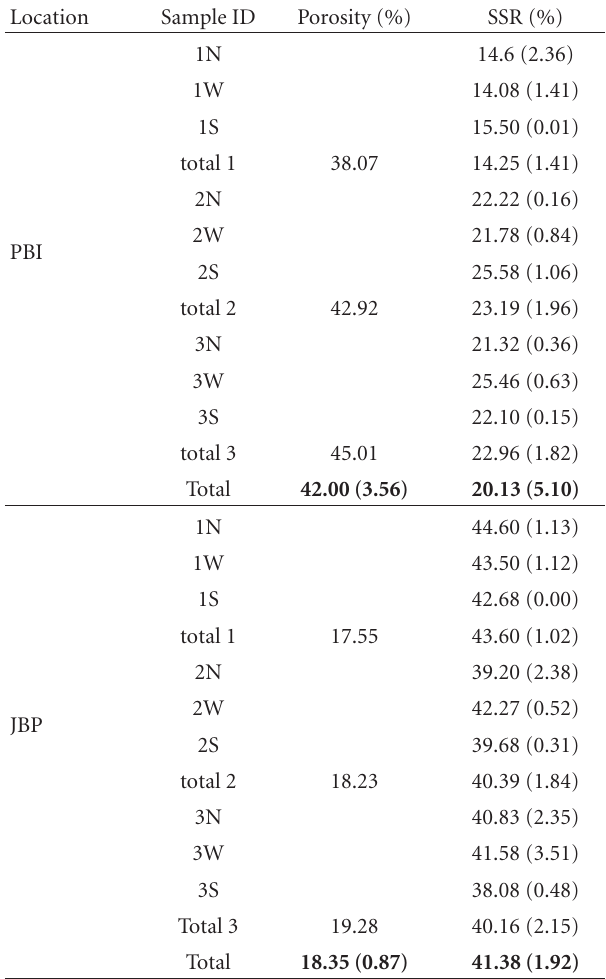
Table 2: Soil surface roughness (SSR) and porosity at the soil surface, expressed in percentages. The values in parentheses are the standard deviations.